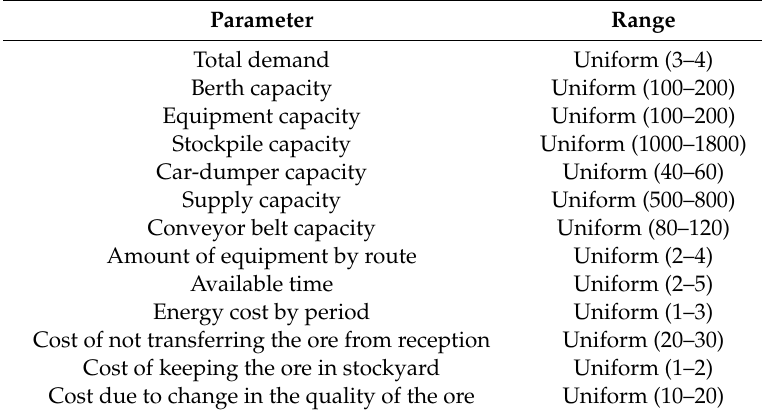
Table 4. Distribution of model parameters for generating instances.